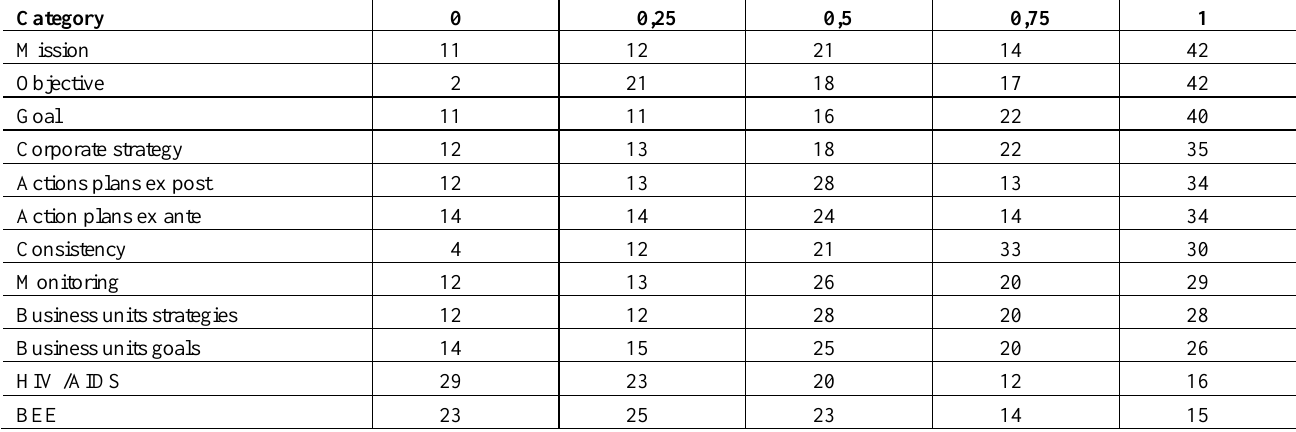
Table 3: Scores for sample companies for the twelve variables